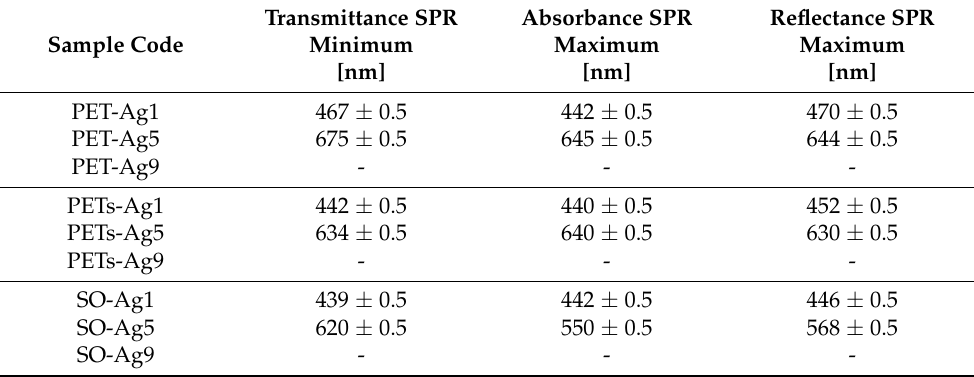
Figure 3 . Optical properties of as-deposited ultrathin films, transmittance, ( a ) on thick PET, ( b ) on thin PETs, ( c ) on optical glass, absorbance, ( d ) on thick PET, ( e ) on thin PETs, ( f ) on optical glass, and reflectance, ( g ) on thick PET, ( h ) on thin PETs, ( i ) on optical glass. Table 4. Position of the SPR-specific maxima obtained from the transmittance, absorbance, and reflectance spectra .